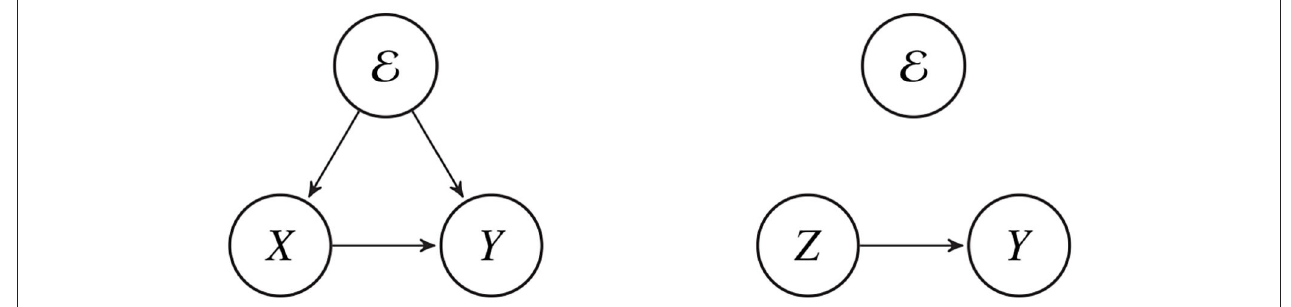
FIGURE 1 | The phonemic transcript, Y , captures a limited set of information about the speech signal, X . The limits of the transcription process are dependent on the language environment, E . Language-independent ASR finds a feature embedding, Z = φ ( X ), such that the relationship between Z and Y is independent of E